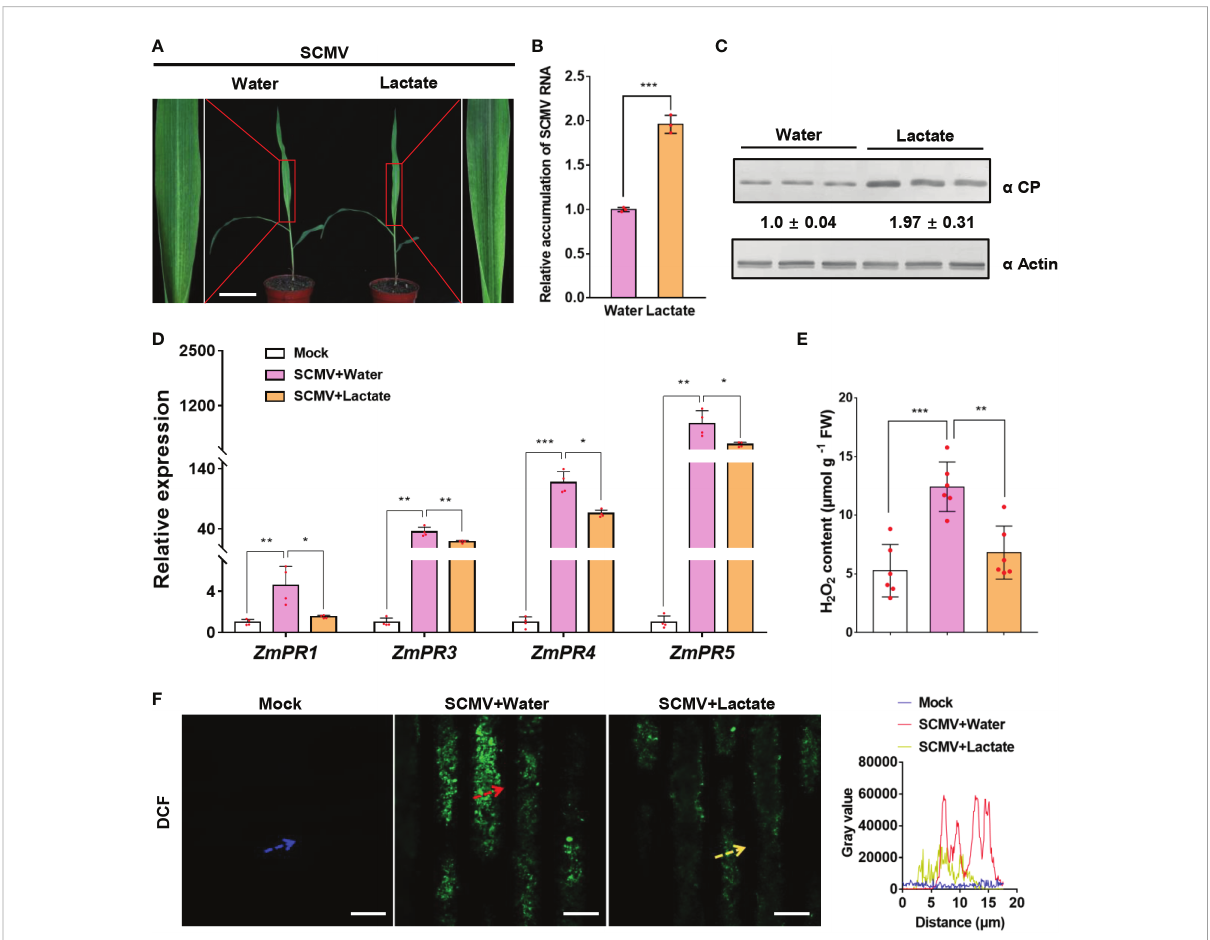
FIGURE 7 Lactate promotes SCMV infection via suppressing plant defense responses. (A) Mosaic symptoms in lactate-treated plants were more severe than that in water-treated plants. Scale bars = 8 cm. (B) Relative accumulation levels of SCMV genomic RNA, determined by RT-qPCR, in 1 SLs of the water- or lactate- treated plants at 5 dpi. The results are represented as the means ± SE (n=3). Statistical differences between the treatments were determined using unpaired Student ’ s t -test (two-tailed), *** P < 0.001. (C) Accumulation levels of SCMV CP in 1 SLs harvested from the water- or lactate-treated plants at 5 dpi through western blotting analysis. The samples harvested from the water-treated plants were used as controls. The detected protein bands were visualized using the ImageJ software. The numbers between the two panels are the relative ratios of SCMV CP accumulated in the lactate-treated plants verses the control plants. The amount of SCMV CP in the control plants is arbitrarily presented as 1.0. The actin bands in the lower panels are used to show sample loadings. (D) PR genes expression was detected by RT- qPCR in mock-inoculated or SCMV-infected plants treated with water or lactate for 24 h. The data are represented as the means ± SE (n=4). Statistical differences between the treatments were determined using unpaired Student ’ s t -test (two-tailed), * P < 0.05; ** P < 0.01; *** P < 0.001. (E) Detection of H 2 O 2 production in mock-inoculated plants or in SCMV-infected maize plants with water or lactate treatment for 24 h. The results are represented as the means ± SE (n=6). Statistical differences between the treatments were determined using unpaired Student ’ s t -test (two-tailed), ** P < 0.01; *** P < 0.001. (F) Detection of H 2 O 2 in mock-inoculated maize leaves or in SCMV-infected maize leaves with water or lactate treatment for 24 h. H 2 O 2 was visualized using the fl uorescence probe CM-H 2 DCFDA (DCF; green fl uorescence). The relative fl uorescence along the dotted line in the photos is represented by the gray value plots. Scale bars = 10 m